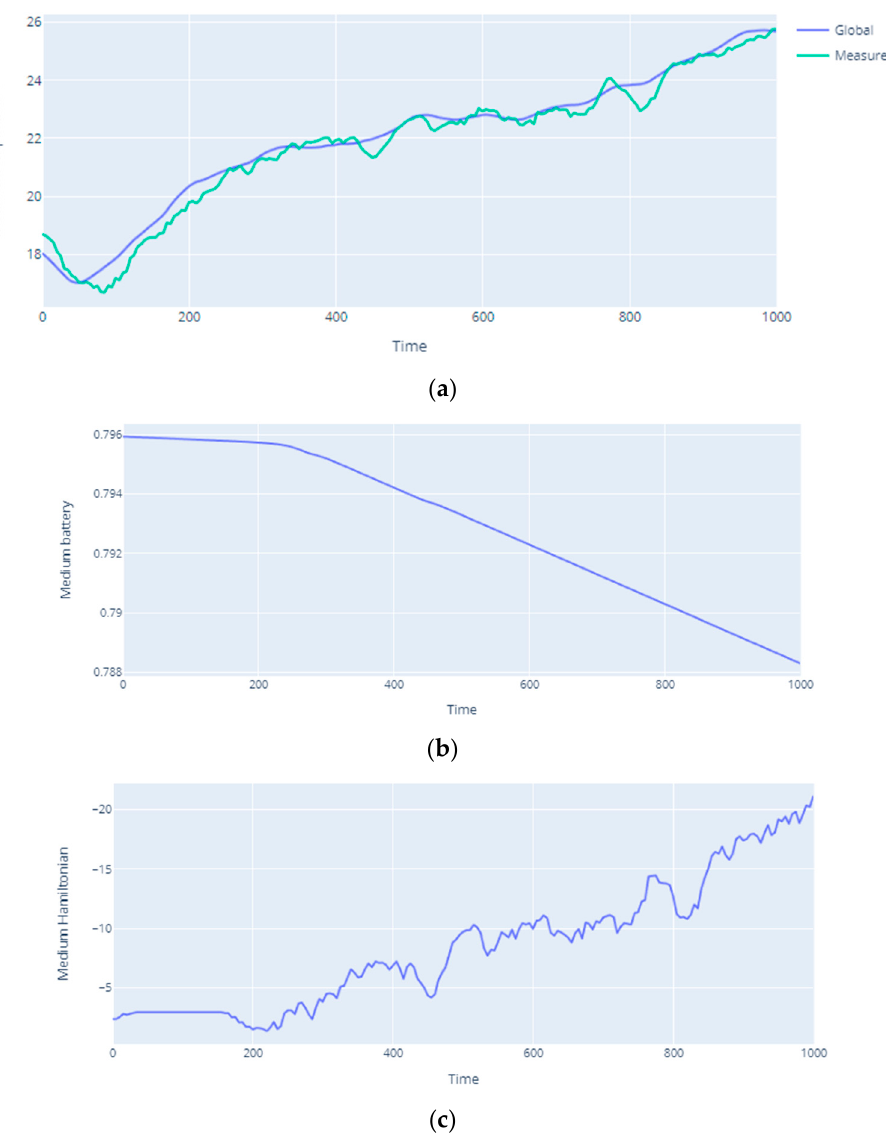
Figure 7. ( a ) Change in average temperature over time for the entire area and at measurement points; ( b ) battery level during simulation; ( c ) change of Hamiltonian value during simulation.